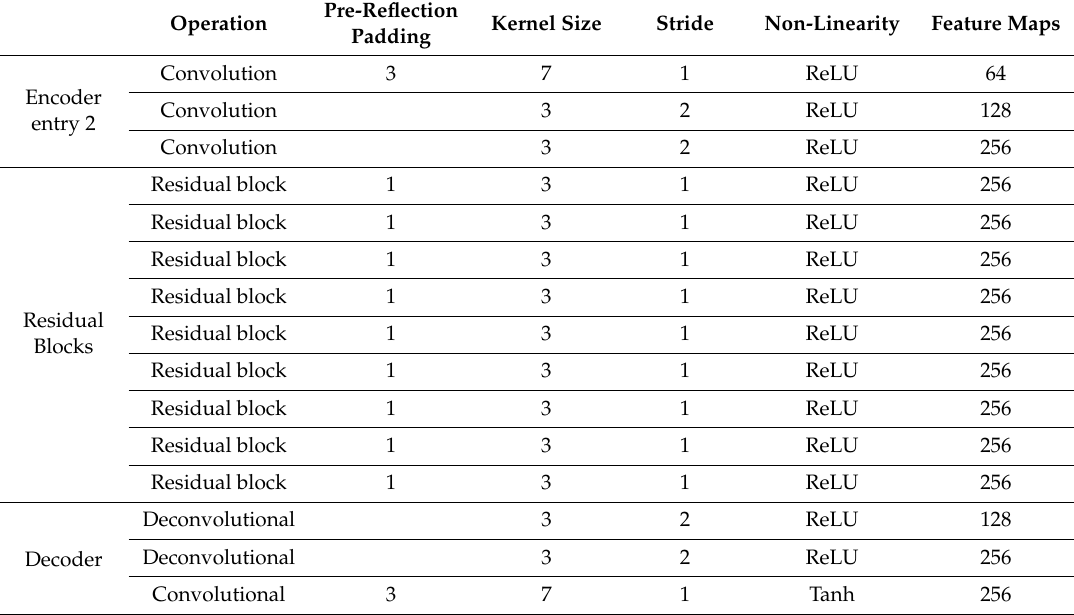
Table 2. Generator Network of